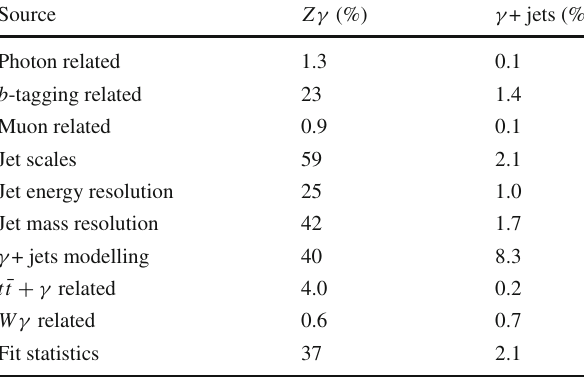
Table 3 Relative impact of the systematic uncertainties on the Z → b ¯ b and γ +jets yields . Multiple independent components have been combined into groups of systematic uncertainties. ‘Jet scales’ refers to the sum in quadrature of the jet energy, mass and substructure